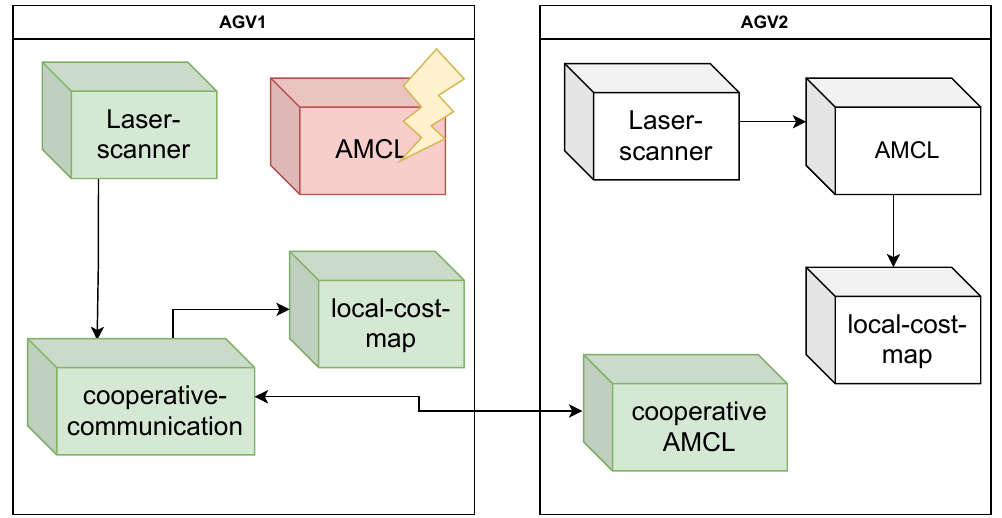
Figure 4. Service and communication setup after local reconfiguration is conducted (red: attacked service, green: services used by